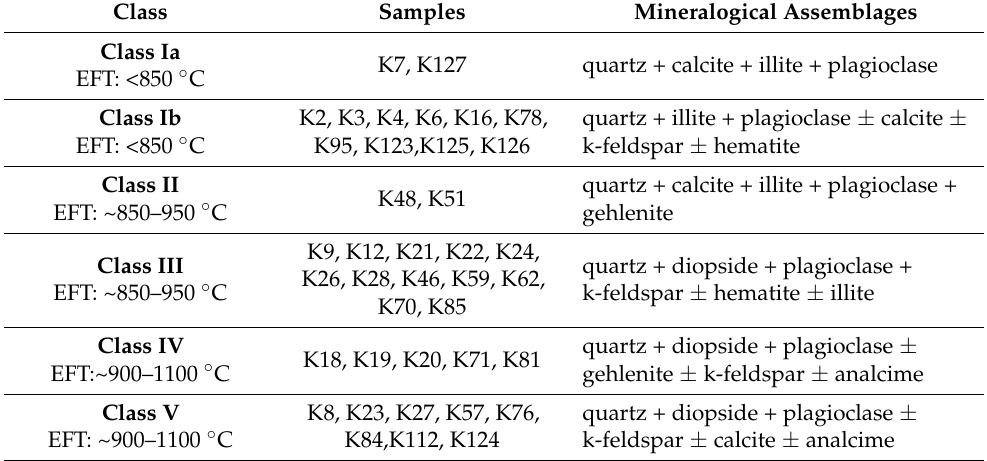
Table 2. Summary of the mineralogical classes and the respective mineralogical assemblages by means of XRPD analysis. (EFT = Equivalent Firing Temperature; ± = not detected in all samples or detected in